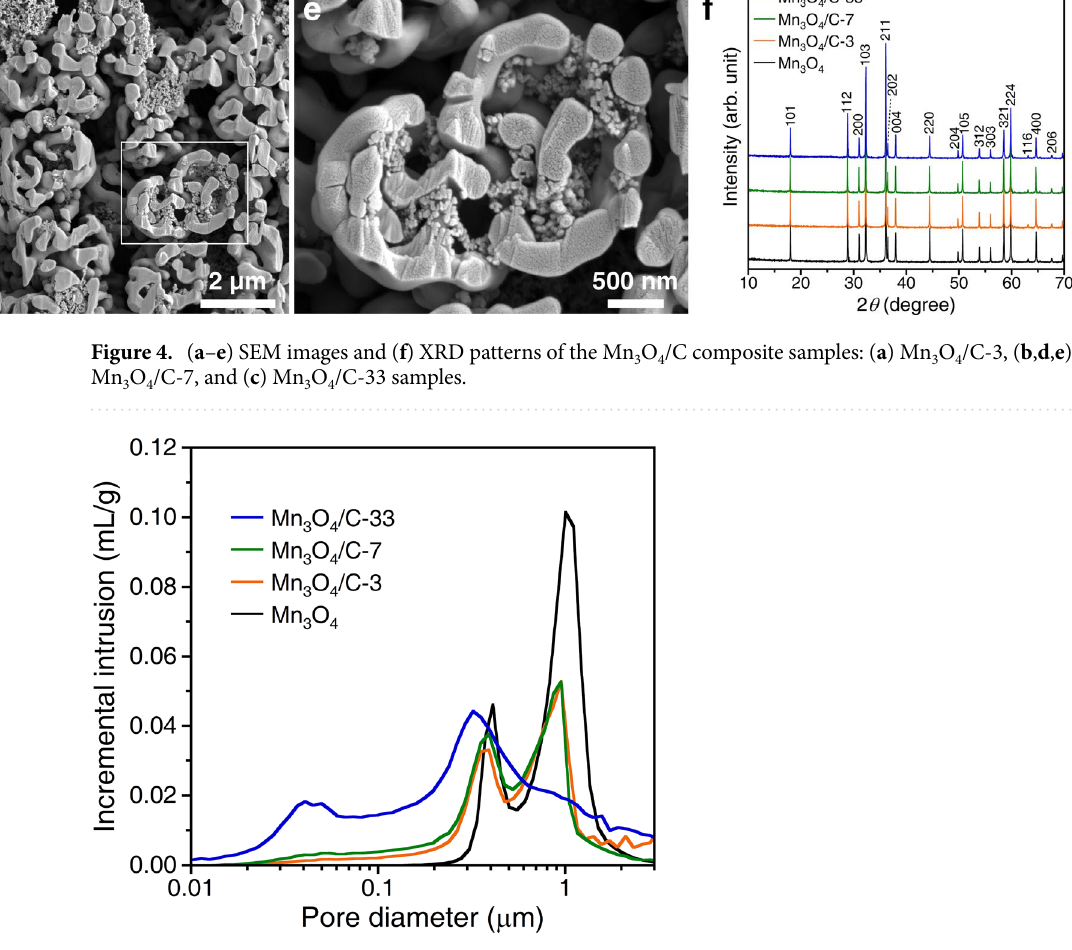
Figure 5. Pore size distribution of the bare Mn 3 O 4 and Mn 3 O 4 /C